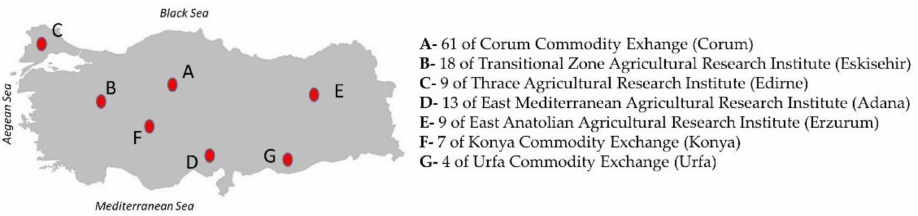
Figure 1. Regional distribution of wheat samples ( n =